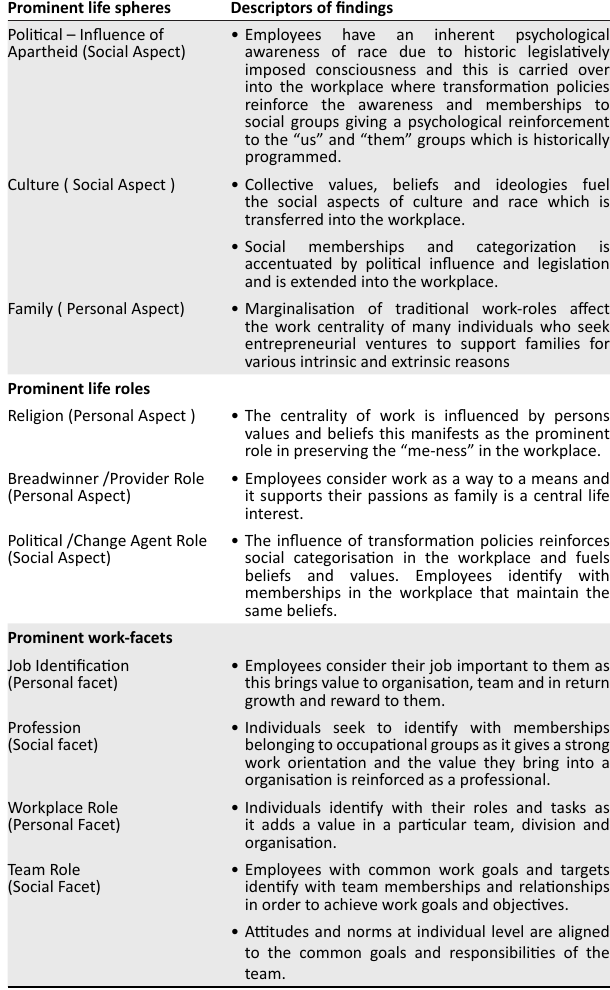
TABLE 2: Influences on work identity in South